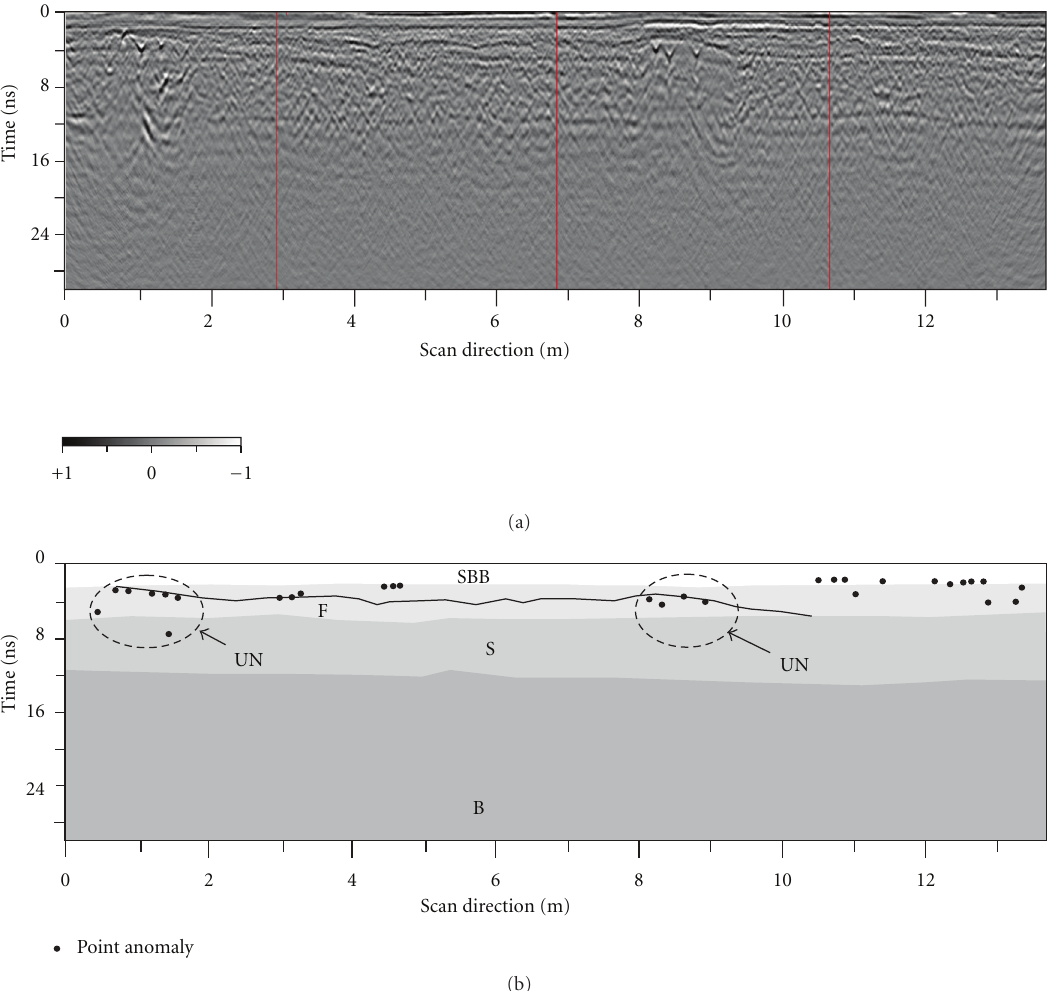
Figure 5: 1600 MHz migrated radar longitudinal section (a) and its line drawing (b) of the undamaged road section reported in Figure 3; di ff erent road layers (SBB: surface-binder-base; F: foundation; S: subgrade; B: bedrock) and buried underground network (UN) are drawn; the corresponding power diagram is reported in Figure